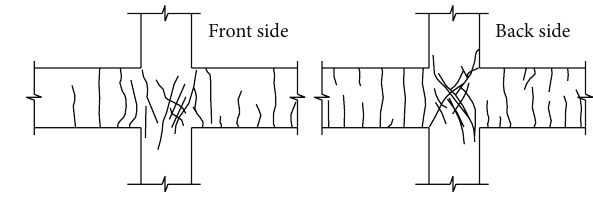
Figure 7: Crack distributing figure.